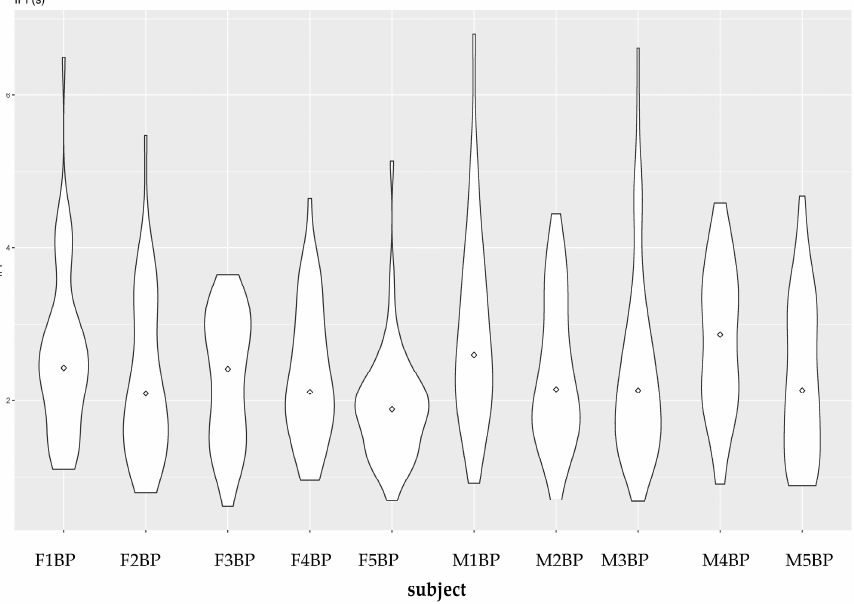
Figure 6. IPI (s) violin plots for the ten Brazilian subjects of the Current Set. The five left-hand plots are from female reciters and the five right-hand plots from male reciters.